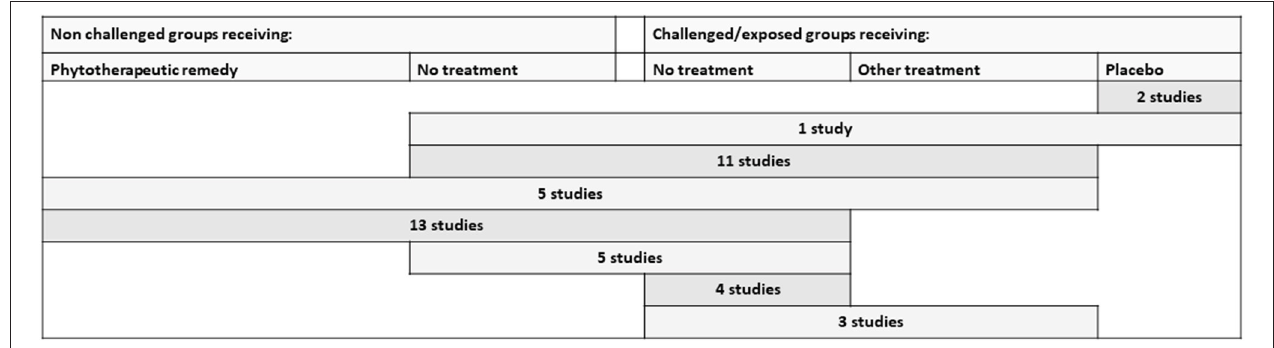
FIGURE 4 | Different types of control groups and the combinations included in the identified studies performed under controlled experimental conditions. Other treatment includes allopathic remedies as well as non-botanical alternative remedies. All rows include a challenged group receiving the studied phytotherapeutic